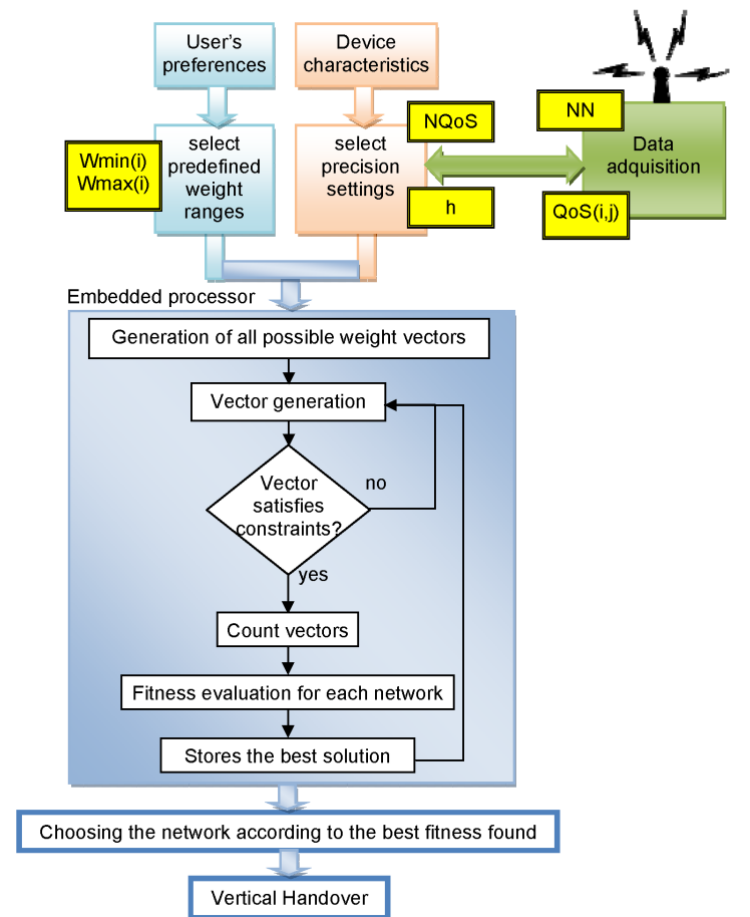
Figure 5. Integration and behavior of SEFI in the architecture of a MS